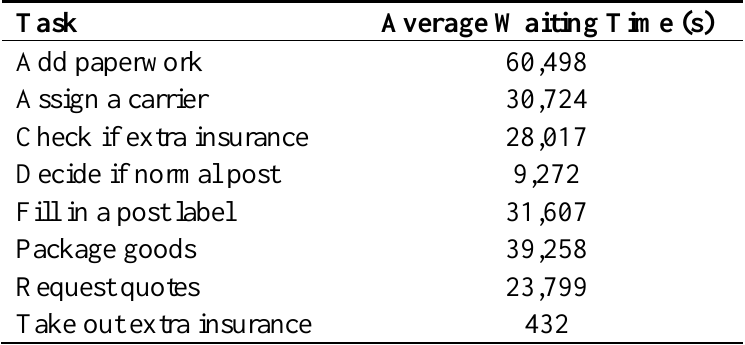
Table 7. Average waiting time, on 100 instances.